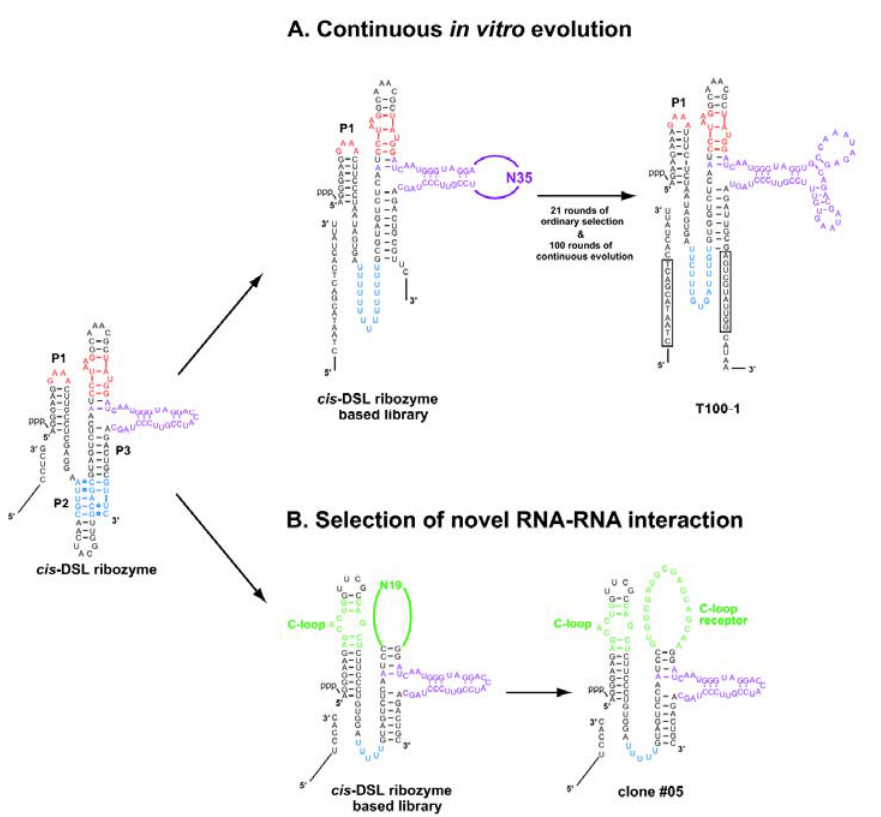
Figure 6. In vitro evolution systems based on the class DSL ribozyme. (A) (left) The cis - DSL ribozyme-based library for in vitro evolution of derivatives adapting to continuous evolution. (right) A representative clone (T100-1) isolated after 21 rounds of ordinary selection followed by 100 successive transfers of continuous evolution. In the T100-1 clone, boxed regions in the substrate and ribozyme form 11 base pairs. (B) (left) The cis - DSL ribozyme-based library for isolation of the receptors recognizing the C-loop motif. (right) The #05 clone possessing a C-loop receptor